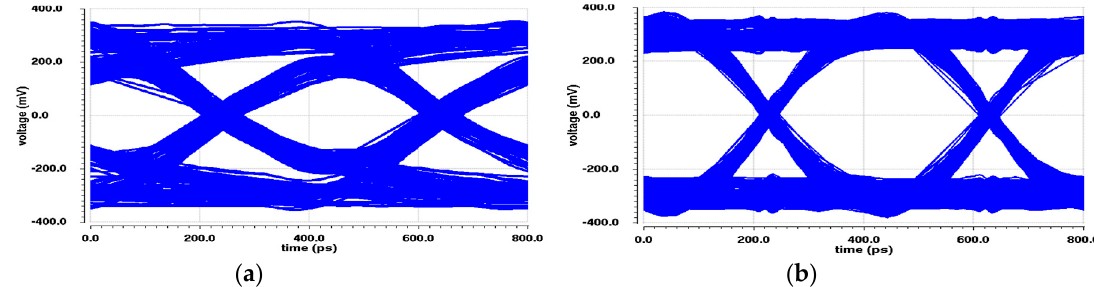
Figure 9. Simulated result of the eye diagram ( a ) without and ( b ) with the pre-emphasis driver.